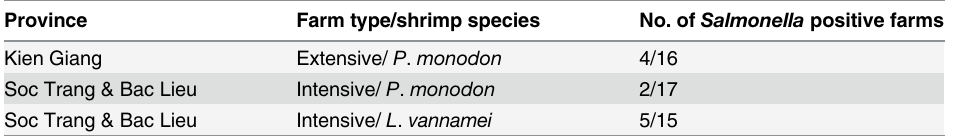
Table 1. Prevalence of Salmonella in extensive and intensive cultured shrimp in the Mekong Delta, Vietnam.